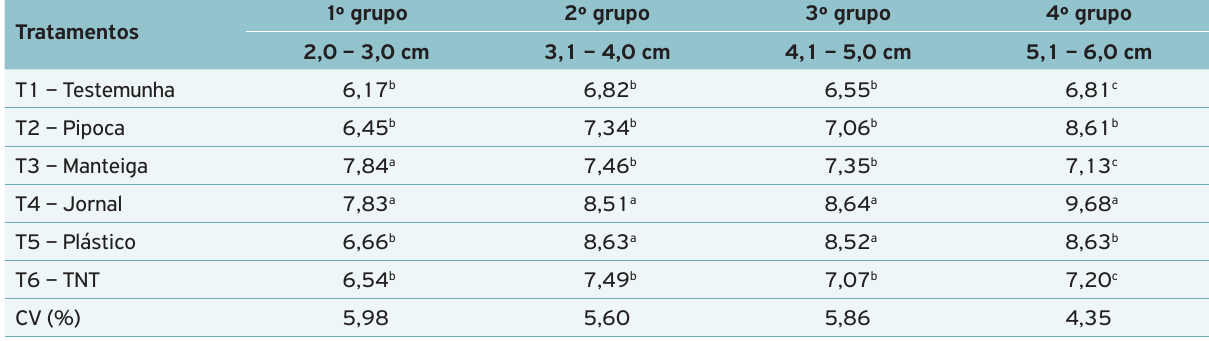
Tabela 2. Valores médios de diâmetros transversais obtidos em quatro grupos de diâmetros de goiabas ensacadas com